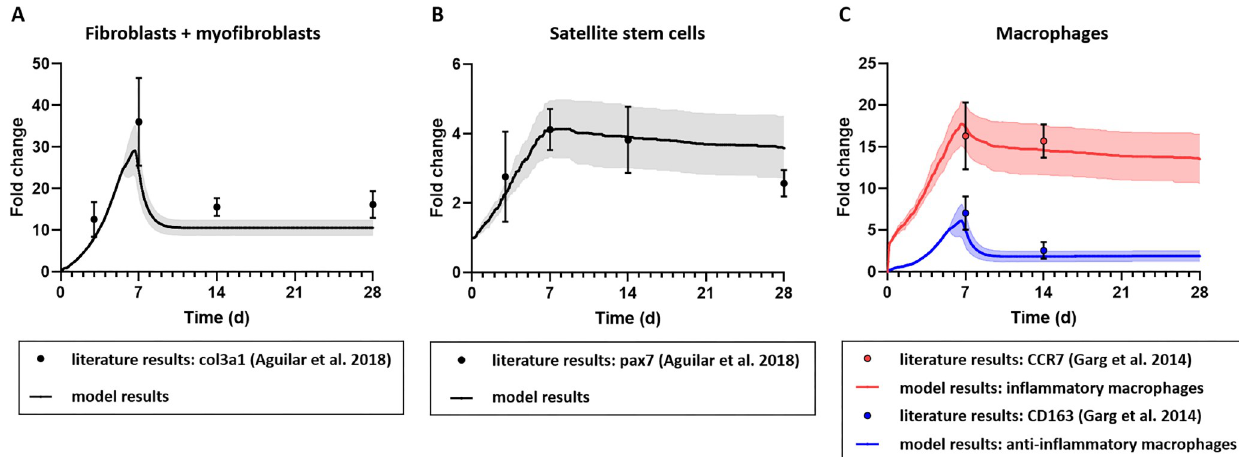
Fig 4. ABM of VML injury regeneration without repair parameterized to capture experimentally reported cell population behaviors. The model replicated an experimentally measured fold change in (A) the number of fibroblasts and myofibroblasts, (B) SSCs, and (C) M1 and M2 macrophages, within the model’s predicted 95% confidence interval. Model results were reported as mean ± 95% confidence interval. Aguilar et al. 2018 experimental data of fibroblasts and satellite cells reported as median ± standard deviation, and Garg et al. 2014 experimental data of macrophages reported as mean ± standard error mean